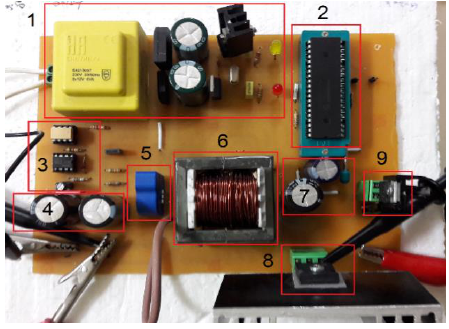
Figure 14. Prototype of the MPPT converter.